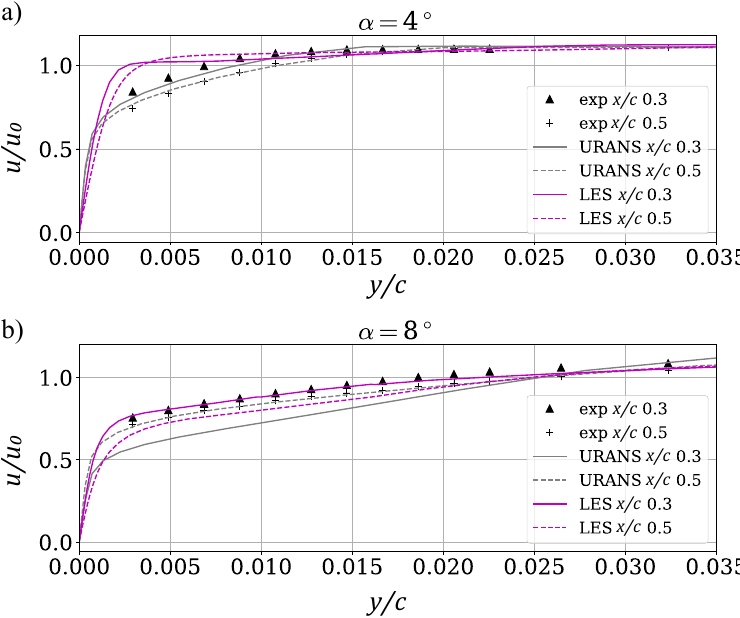
Figure 6. RANS, LES and experimental boundary layer profiles: ( a ) α 0 = 4 ◦ and ( b ) 8 ◦ at z ref / c = 0.24; Mesh y + = 1, nc = 15